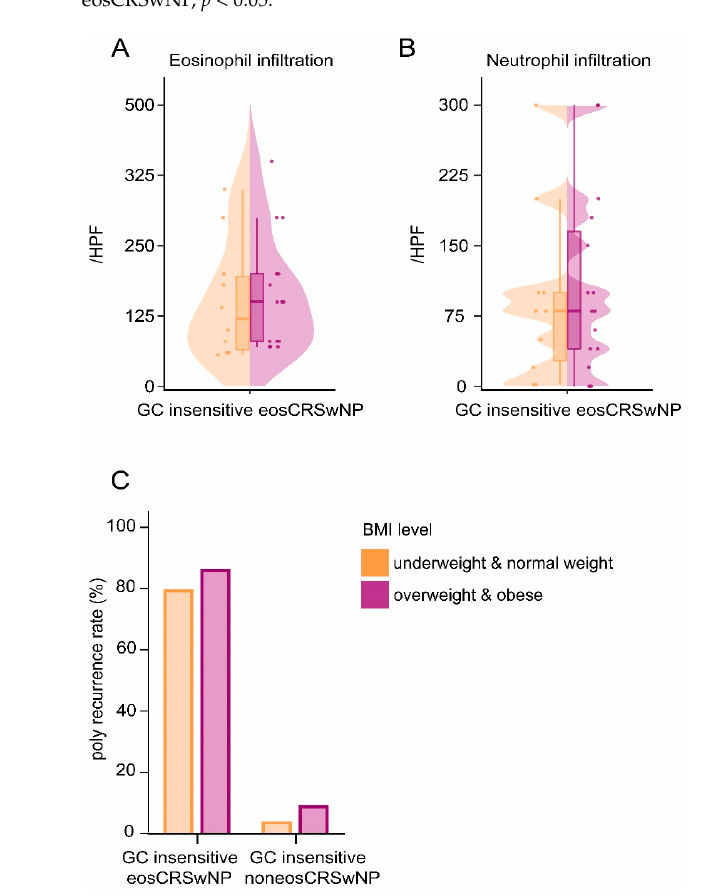
Figure 3. ( A ) Eosinophil infiltration absolute counts in nasal polyp tissues of underweight & normal weight and overweight & obese glucocorticoid (GC) insensitive eosCRSwNP patients. ( B ) Neutrophil infiltration absolute counts in nasal polyp tissues of underweight & normal weight and overweight & obese GC insensitive eosCRSwNP patients. ( C ) Polyp recurrence rates of underweight & normal weight and overweight & obese GC insensitive eosCRSwNP and noneosCRSwNP patients.